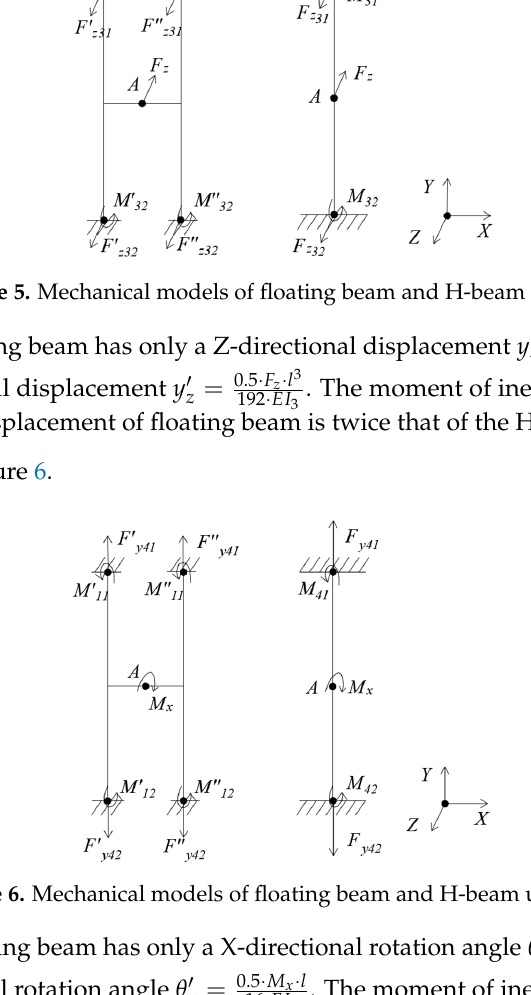
Figure 4. Mechanical models of floating beam and H-beam under F y.